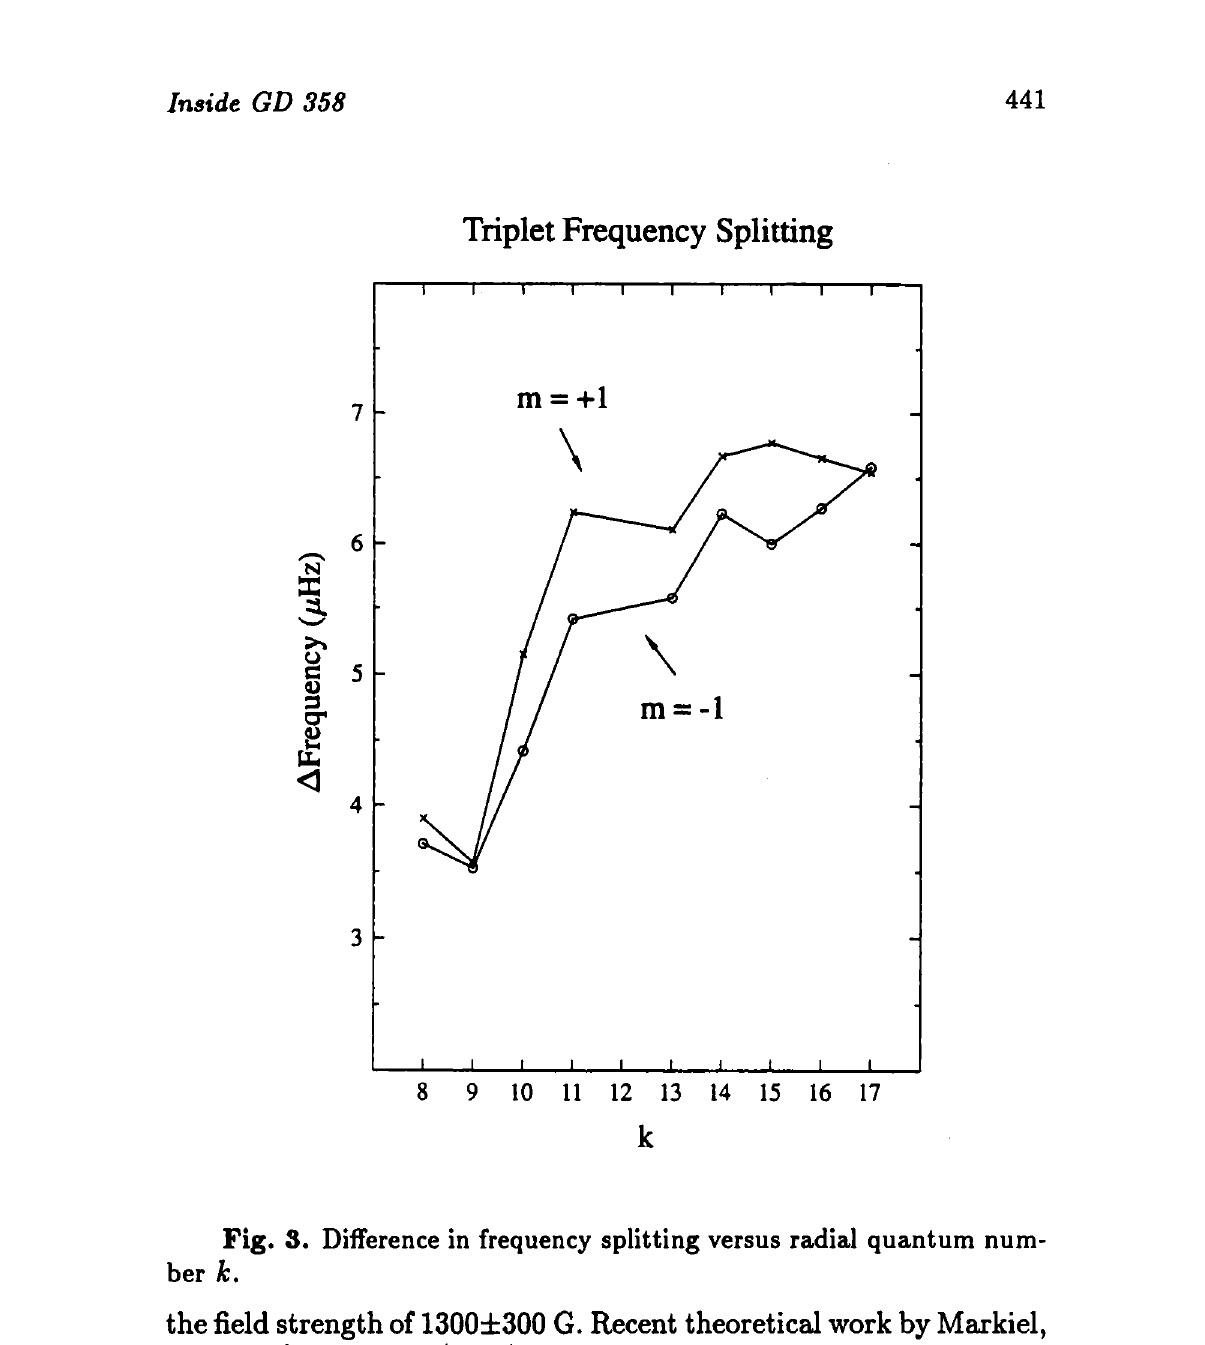
Fig. 3. Difference in frequency splitting versus radial quantum num- ber